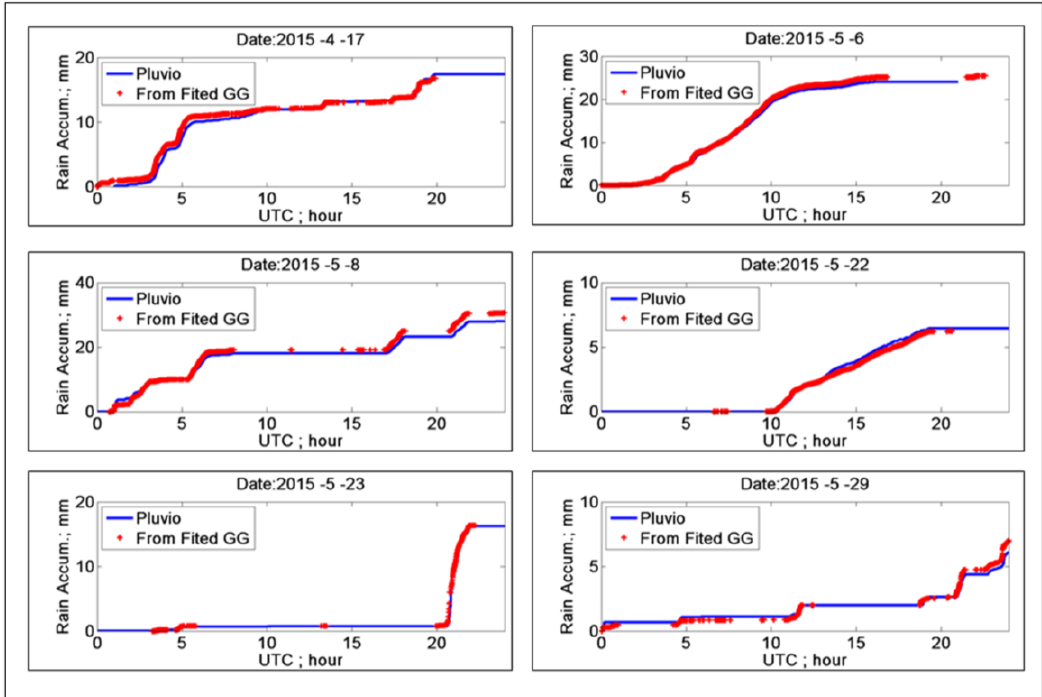
Figure 5. Rain accumulations from GG fitted one-minute DSDs (red) compared with Pluvio measurements for six example events in GXY.